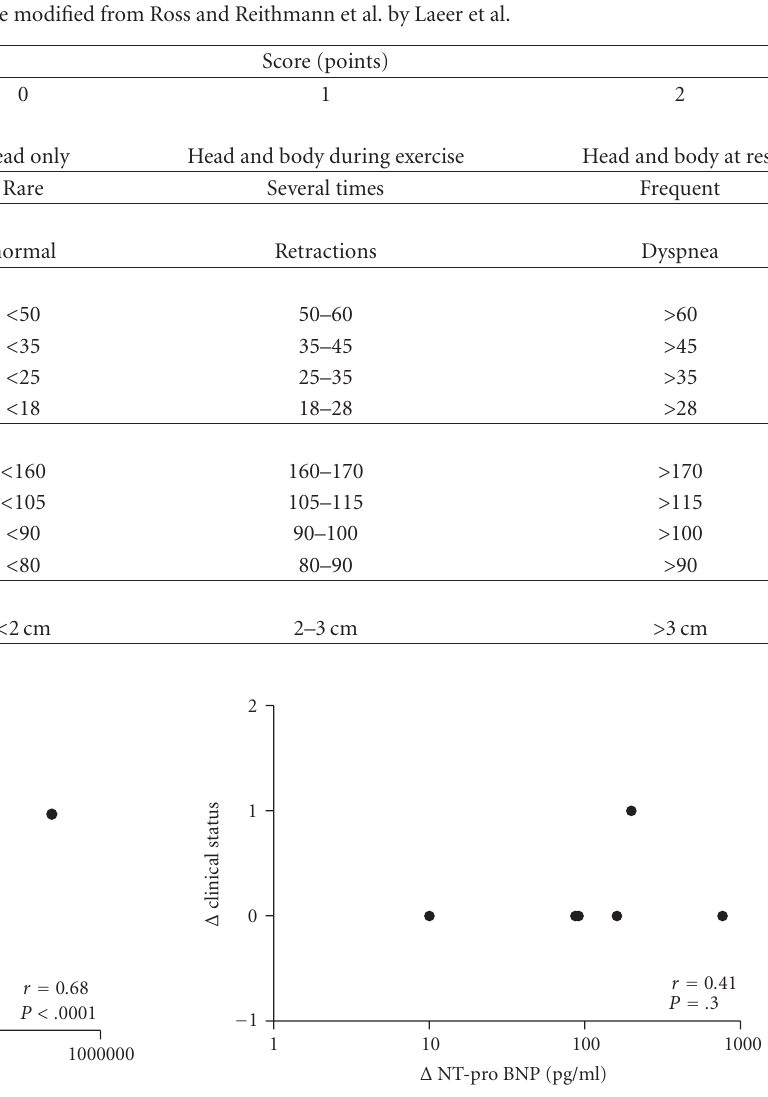
Figure 3: Clinical status and NT-proBNP (log 10, pg/mL) in patients without change after the